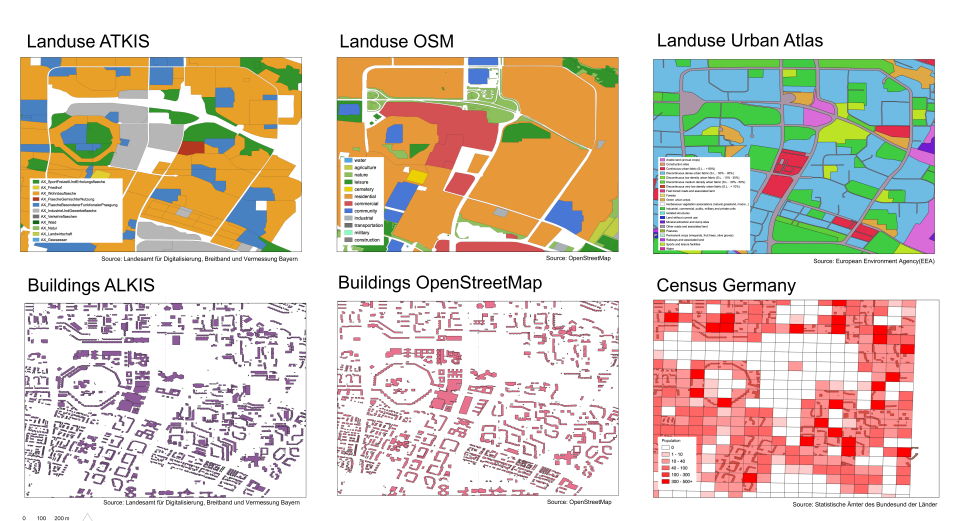
Figure 2. Core spatial data